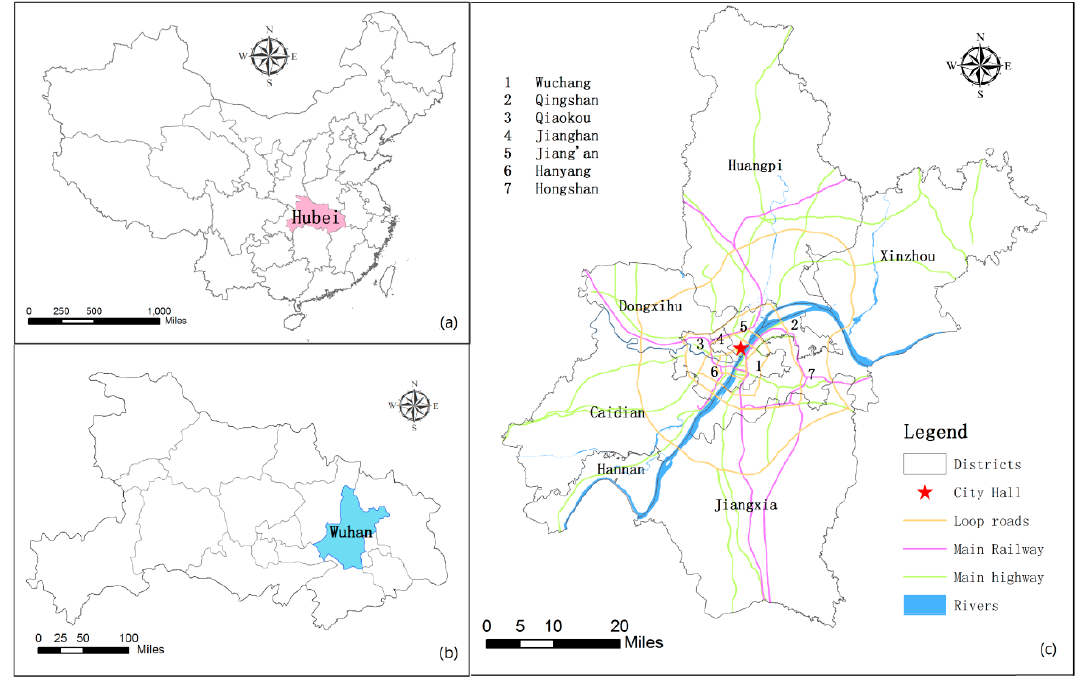
Figure 1. The study site. ( a ) Hubei province in China; ( b ) Wuhan city in Hubei Province; and ( c ) the basic map of Wuhan city.